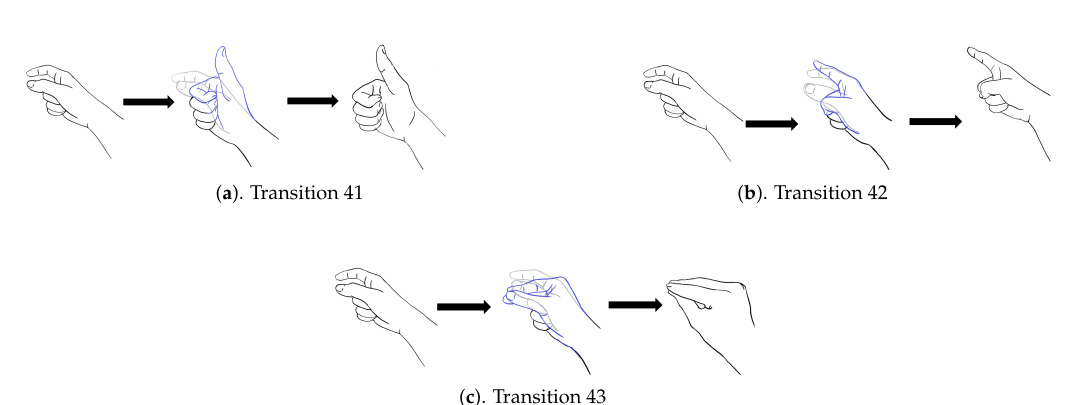
Figure 11. Three transitions associated with Gesture 3: Transition 31, Transition 32 and Transition 34, where Transition ij denotes transition from Gesture i to Gesture j .